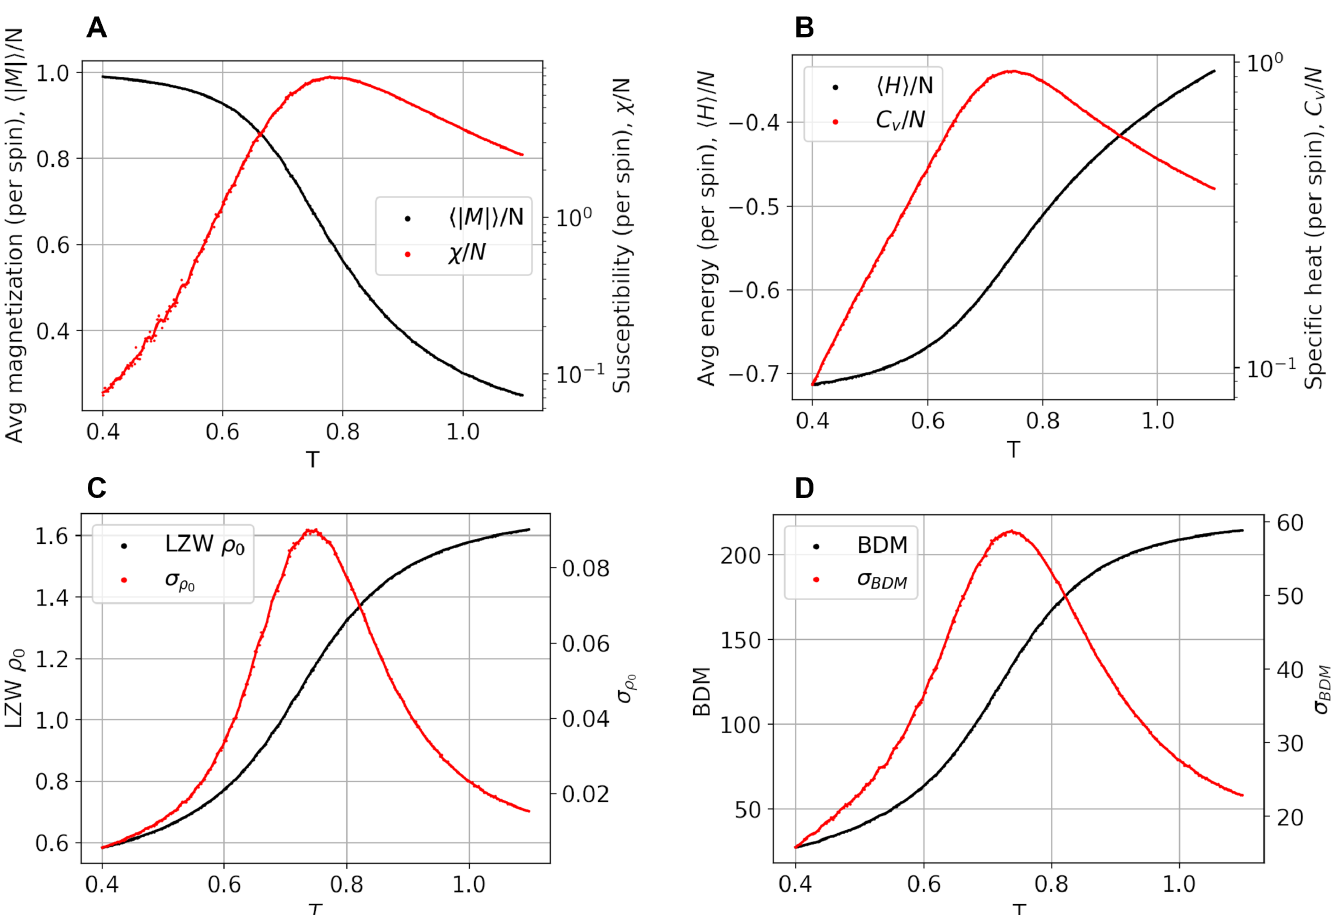
Fig 3. Phase diagram for global archetype model as a function of temperature. A) Global susceptibility and magnetization, B) energy and heat capacity. C) LZW complexity ( ρ 0 ) and its standard deviation, and D) BDM complexity and its standard deviation. The Metropolis algorithm has been run for 10 8 spin flip tests for each temperature to obtain these plots.